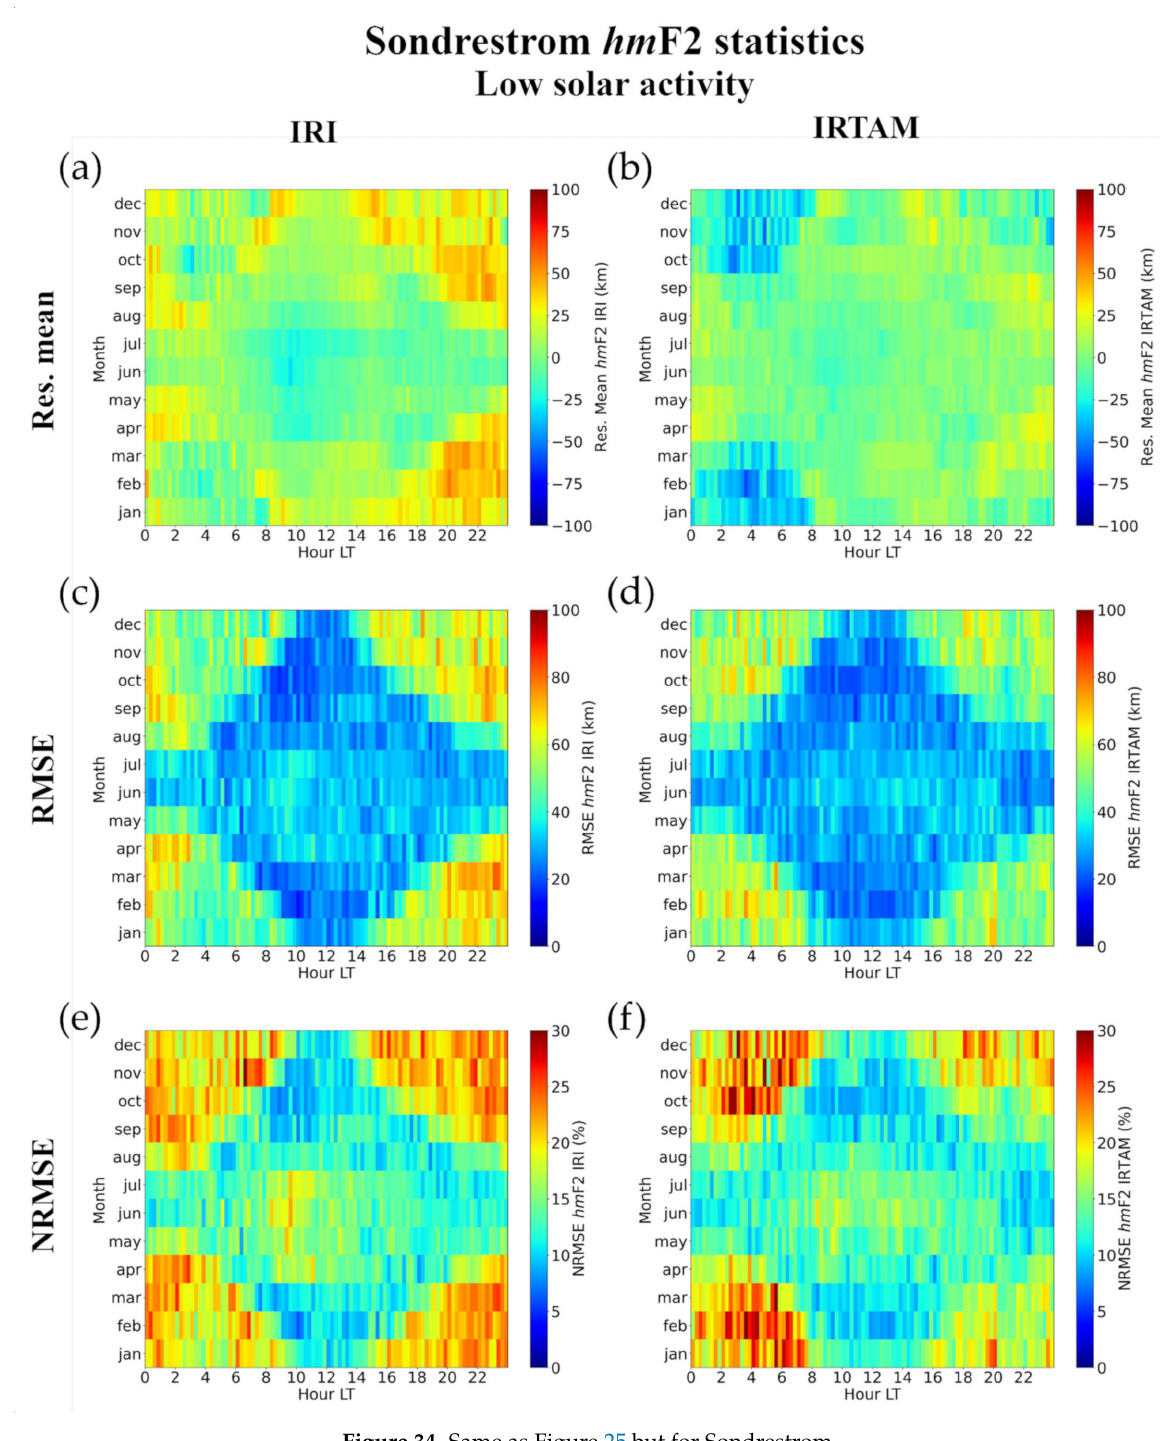
Figure 34. Same as Figure 25 but for